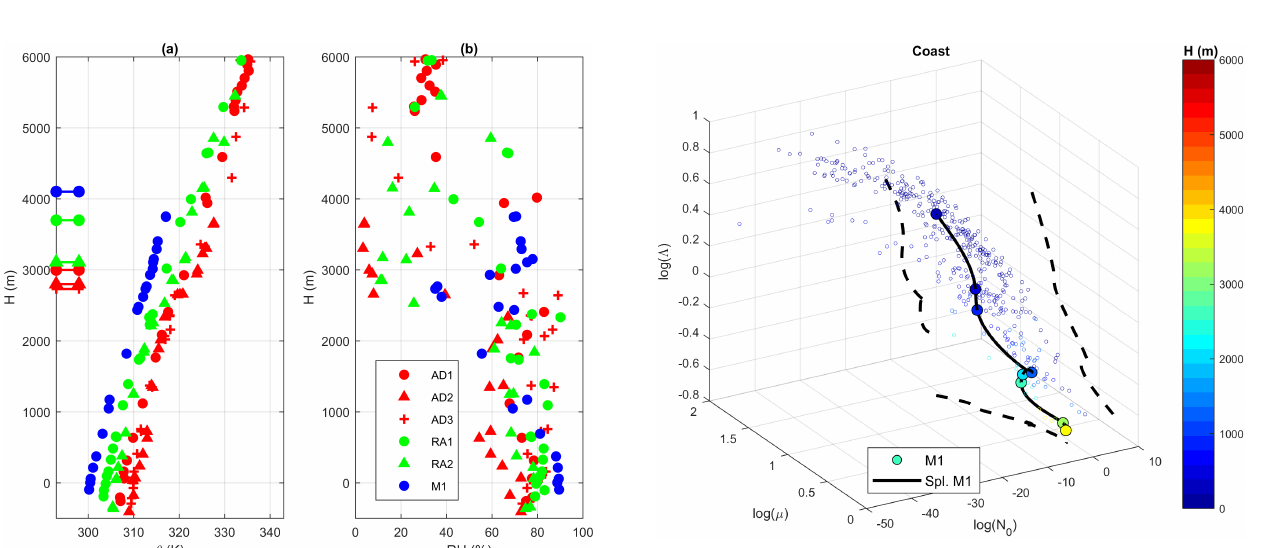
Figure 4. Average vertical profiles of potential temperature (a) and relative humidity (b) for flights over the Atlantic coast, remote Amazon, and arc of deforestation. The markers in the left vertical axis in (a) represent the altitude of the 0 ◦ C isotherm for the differ- ent flights. Altitudes are relative to cloud base ( H , negative values are below clouds). θ and RH are calculated as averages of level flight legs outside clouds.